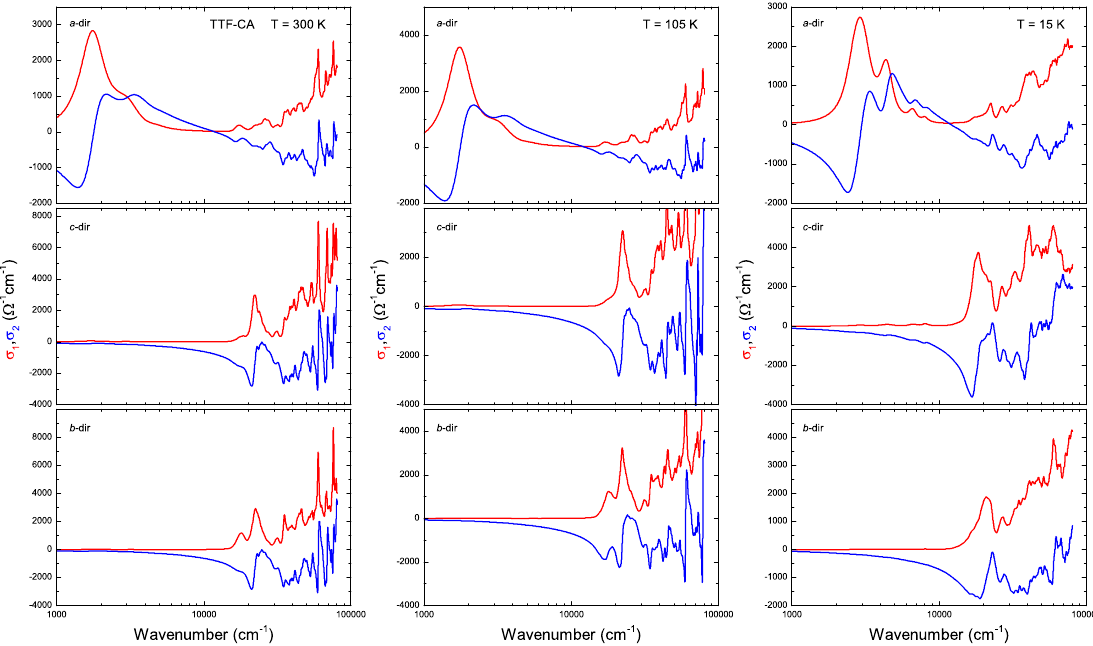
Figure 12. Real and imaginary parts of the frequency dependent conductivity σ 1 ( ν ) (red lines) and σ 2 ( ν ) (blue lines) of TTF-CA calculated by density functional theory described in Appendix B for all three crystallographic axes. The left column displays the optical conductivity at ambient conditions, the central column at T = 105 K and the right column at low temperatures ( T = 15 K). For the calculation, the structural data of TTF-CA were used, taken at the corresponding temperatures